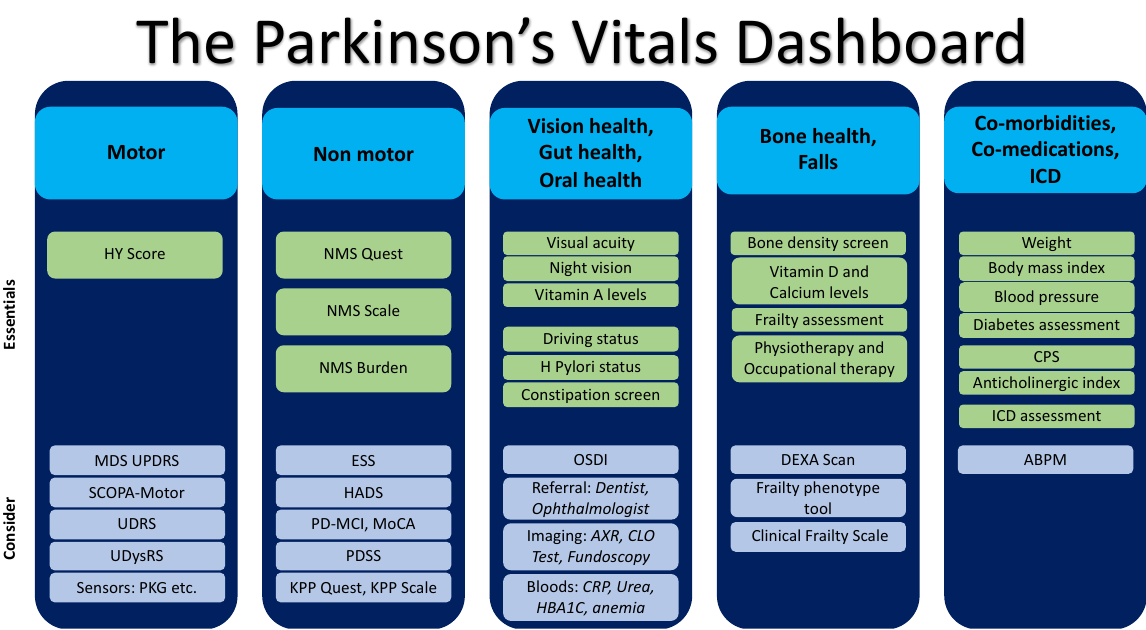
review and consider some optional investigations and assessments if time permits. ABPM ambulatory blood pressure monitoring; AXR abdominal X-ray; CLO campylobacter-like organism test; CPS co-morbidities polypharmacy score; CRP C-reactive protein; DEXA dual energy X-ray absorptiometry scan; ESS Epworth Sleepiness Scale; HADS Hospital anxiety and depression scale; HY Hoehn and Yahr, H Pylori helicobacter pylori; ICD impulse control disorder; KPP King’s Parkinson’s Pain; MCI mild cognitive impairment; MDS-UPDRS Movement disorder society unified Parkinson’s disease rating scale; MoCA Montreal Cognitive Assessment; NMS nonmotor symptoms; NMS Quest NMS questionnaire; OSDI Ocular Surface Disease Index; PDSS PD Sleep Scale; PKG Parkinson’s kine- tograph; SCOPA-motor Scales for outcomes in Parkinson’s disease motor function; UDRS unified dystonia rating scale; UDysRS unified dyskinesia rating